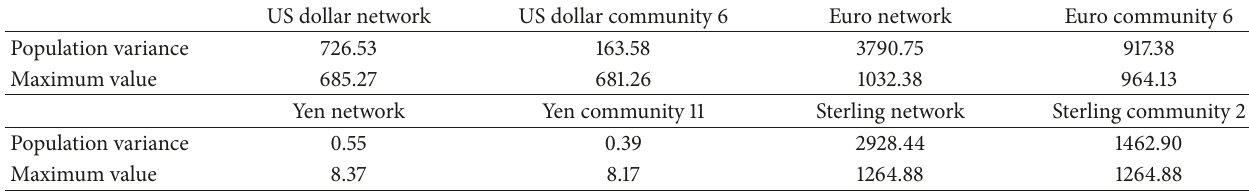
Table 7: Statistical results of the community containing the most fragments of US dollar, Euro, Yen, and Sterling exchange rate